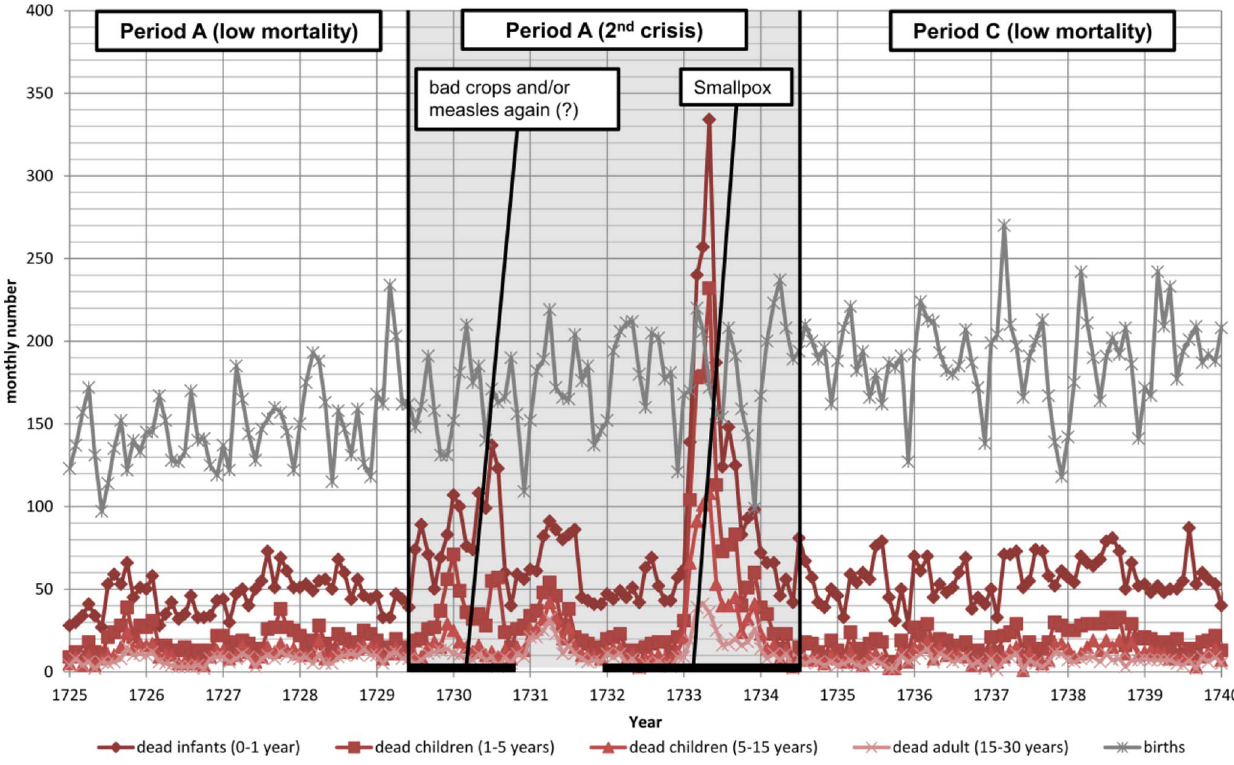
Figure 2. Graph showing the monthly number of births, dead infants (0–1 year), small children (1–5 years), children (5–15 years), and young adults (15–30 years) from 1725 until 1740. The period between Jun. 1, 1729 and Jun. 30, 1735 is characterized by two periods of increased mortality in quick succession and is considered as a single crisis period.